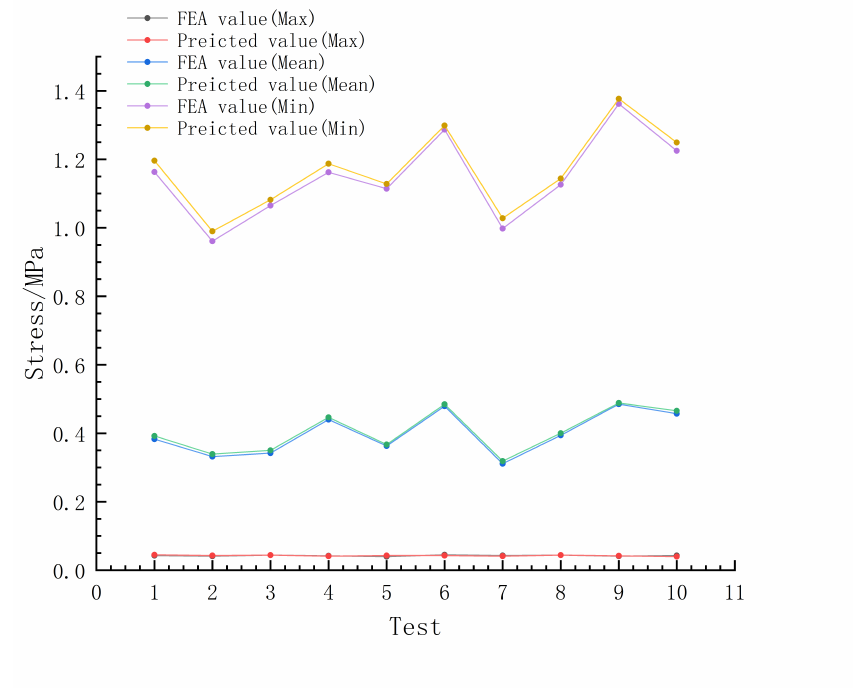
Figure 10. Cross